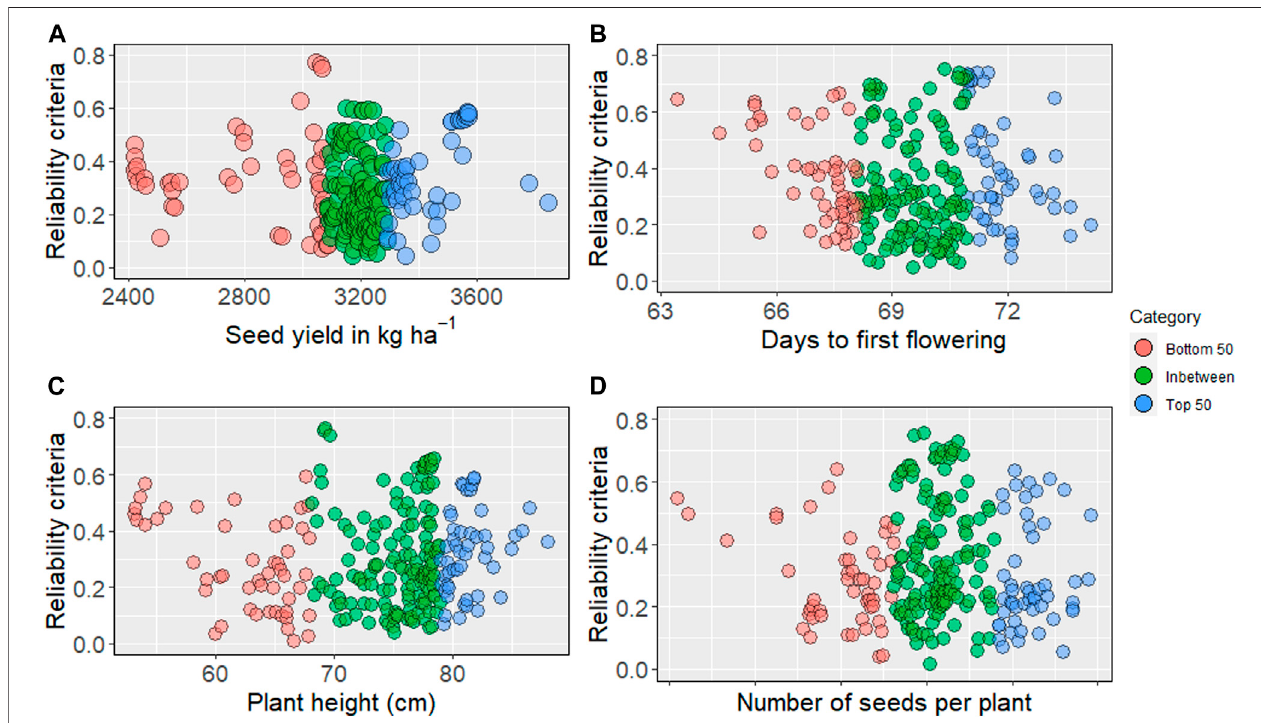
FIGURE 3 | Reliability criteria for nonphenotyped lines: the top 50 of genomic estimated breeding values are blue, and bottom 50 are in red, intermediates are in green. (A) reliability estimates for seed yield (kg ha − 1 ), (B) days to fi rst fl owering, (C) plant height, (D) number of seeds per plant.